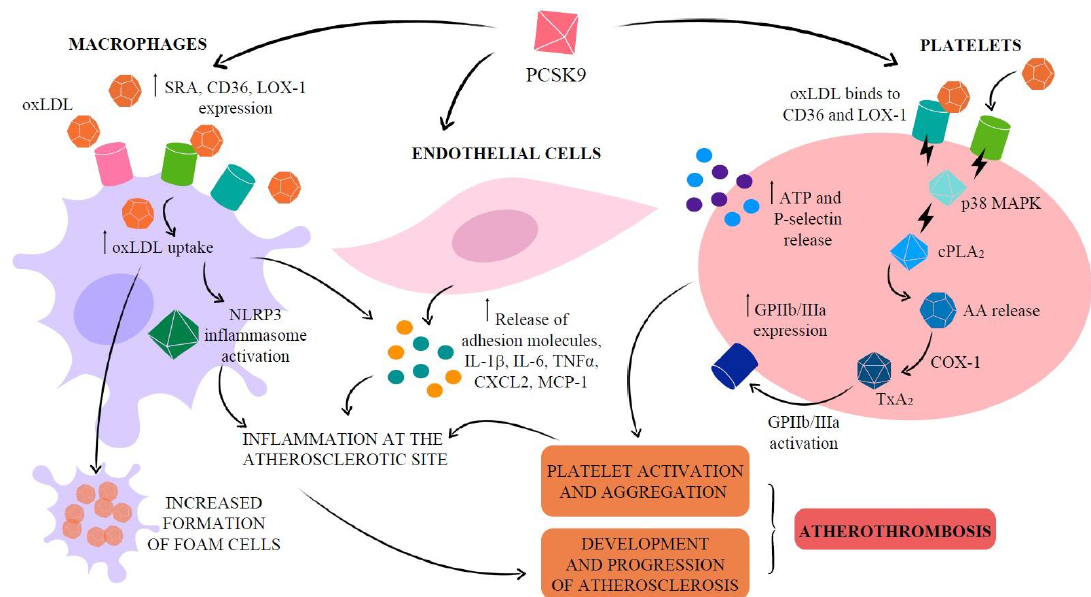
Figure 4. Molecular pathways implicated in the PCSK9 effects on endothelial cells, macrophages and platelets, lead- ing to atherothrombosis. LDL: low-density lipoprotein; oxLDL: oxidized LDL; LOX-1: lectin-like oxidized low-density lipoprotein receptor 1; SRA: scavenger receptor A; CD36: cluster of differentiation 36; NLRP3: NOD-like receptor pyrine domain-containing protein 3; PLA 2 : phospholipase A 2 ; AA: arachidonic acid; COX: cyclooxygenase; TX: thromboxane; GPIIb/IIIa: glycoprotein